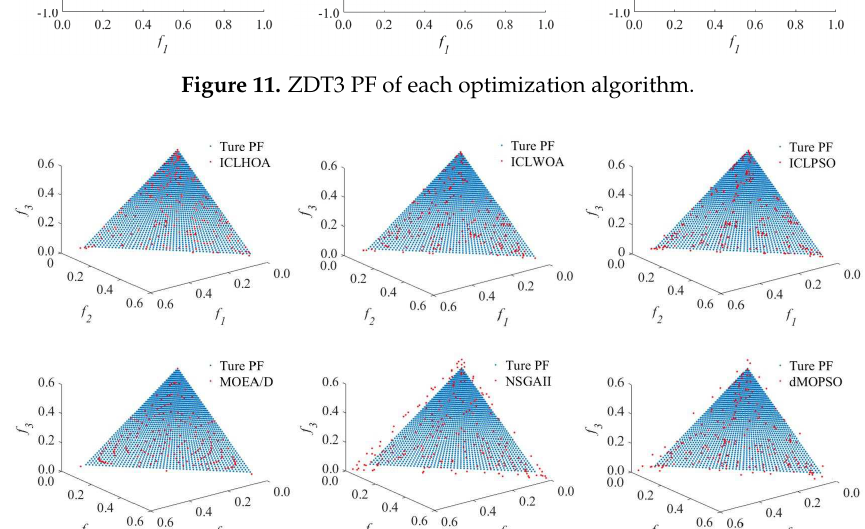
Figure 12. DTLZ1 PF of each optimization